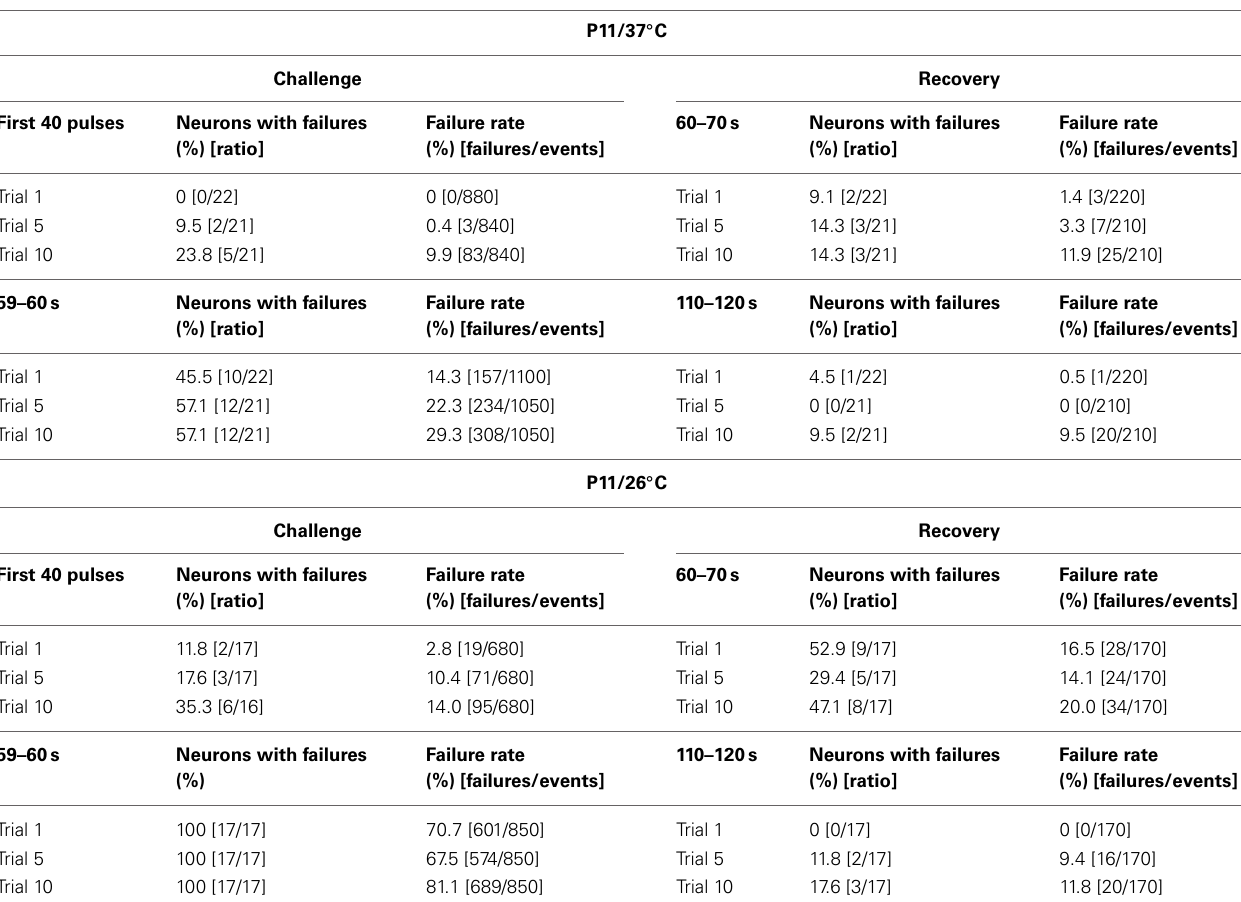
Table 4 | Failure rate analysis during challenge and recovery periods upon prolonged stimulation (20min,